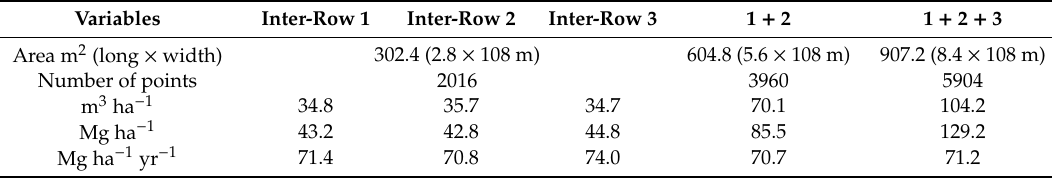
Table 2. Soil mobilization rates obtained using ISUM for one, two, and three